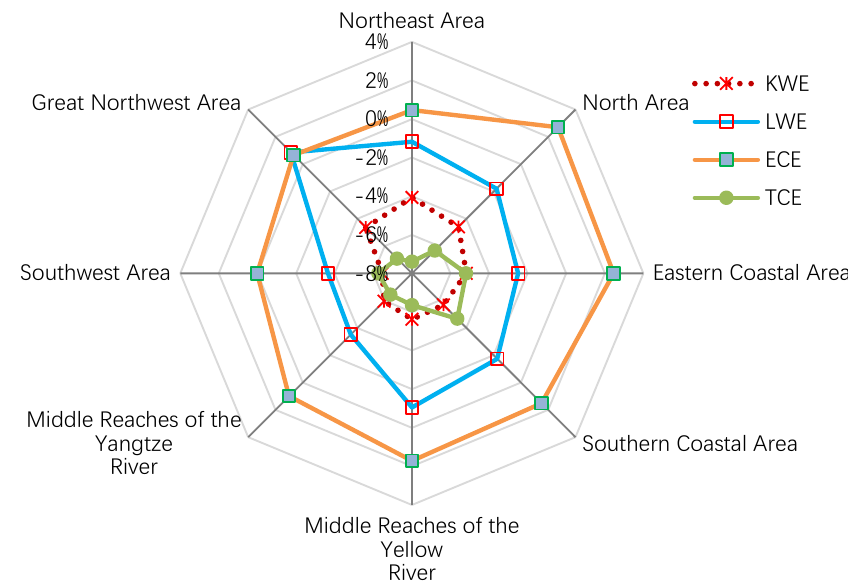
Figure 6. Differences in the driving factors of IWEI change in the eight areas, 2003–2015. ECE: the effect of technical efficiency change; TCE: the effect of technological change; KWE: the effect of capital–wastewater substitution; LWE: the effect of labor–wastewater substitution; IWEI: industrial wastewater emission intensity.